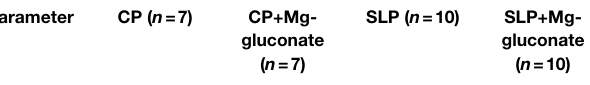
TABLE 3 | Effects of the treatment with Mg-gluconate on blood pressure and urinary protein excretion in control (CP) and salt-loaded pregnant rats (SLP). Parameter